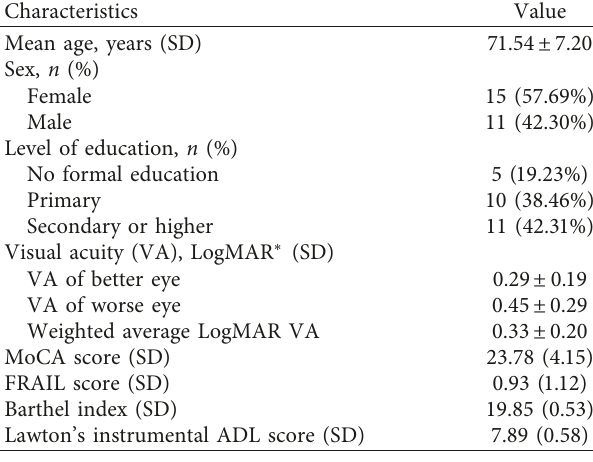
Table 1: Descriptive statistics for demographic and clinical variables.